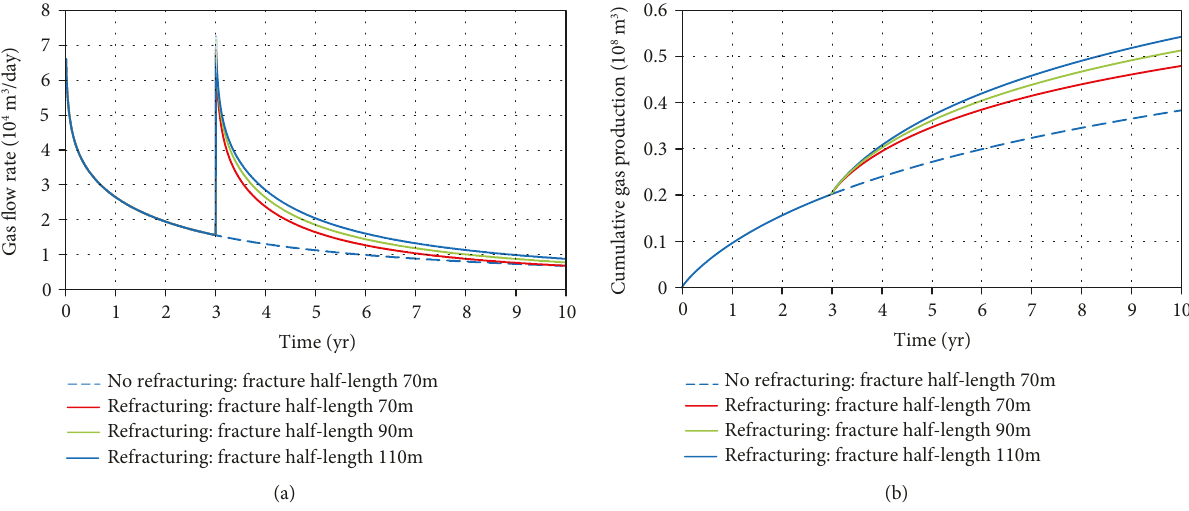
Figure 11: E ff ects of hydraulic fracture half-length on: (a) gas fl ow rate and (b) gas fl ow rate of refracturing through new perforation